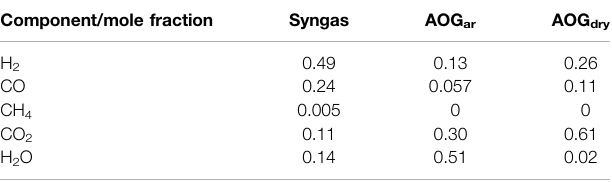
TABLE 6 | Composition of fuel gases in the Bio-SOFC plant. Component/mole fraction Syngas AOG ar